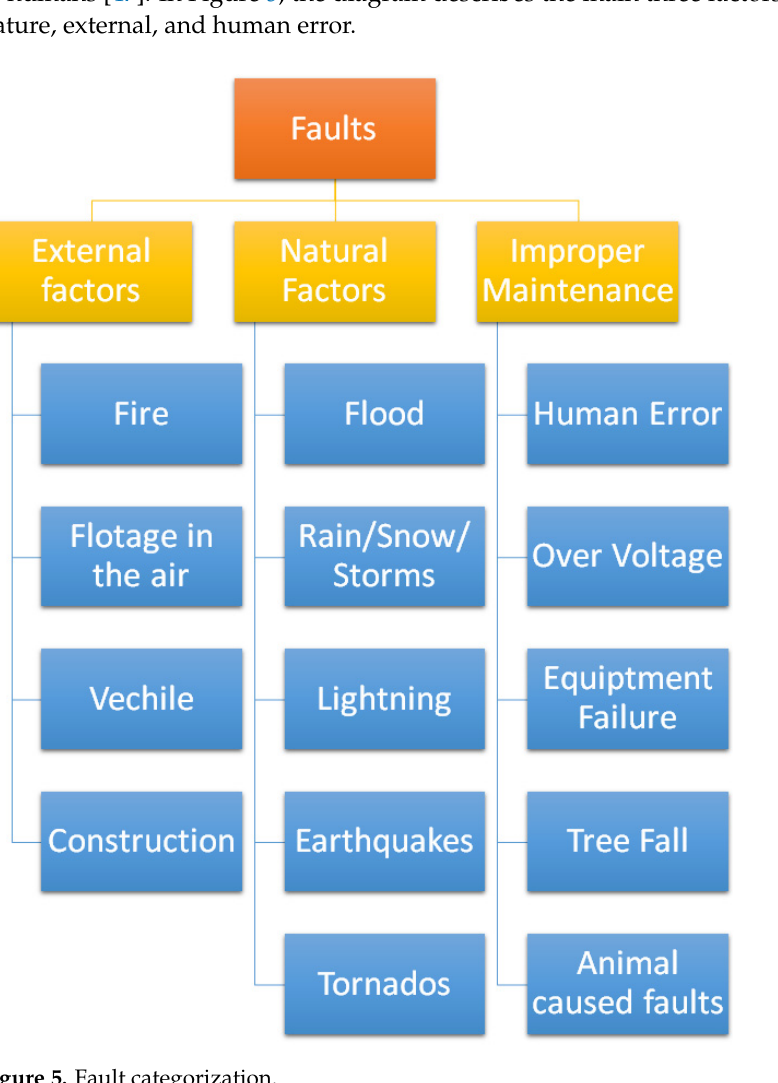
Figure 5. Fault categorization.